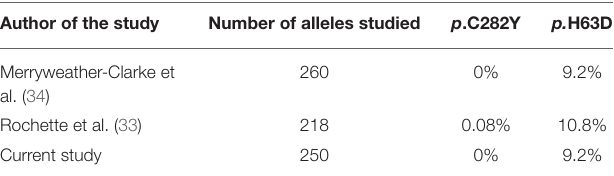
TABLE 3 | Comparison of the allele frequencies of the mutant alleles in the HFE gene with the current